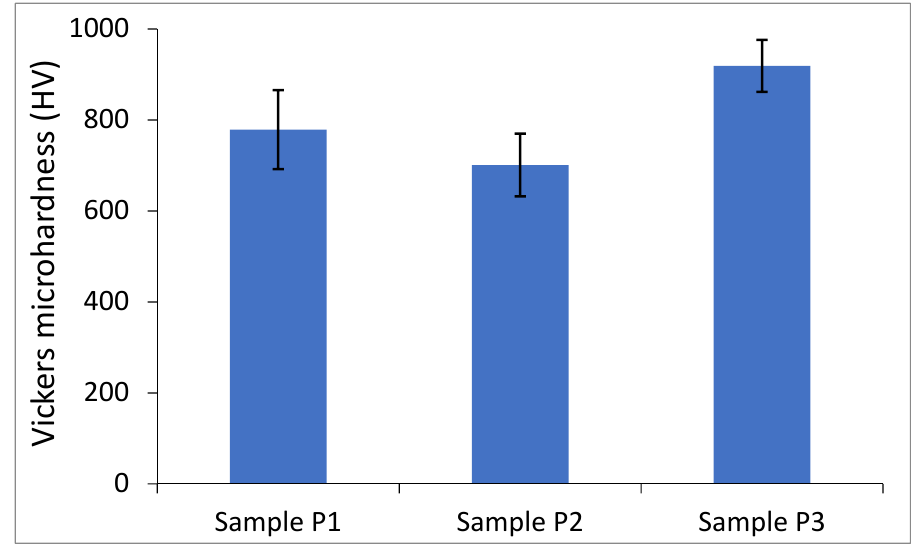
Figure 8. Comparison of the Vickers microhardness HV 0.2 of the samples: P1 (100 J/mm 3 ), P2 (140 J/mm 3 ), and P3 (70 J/mm 3 + 100 J/mm 3 ).